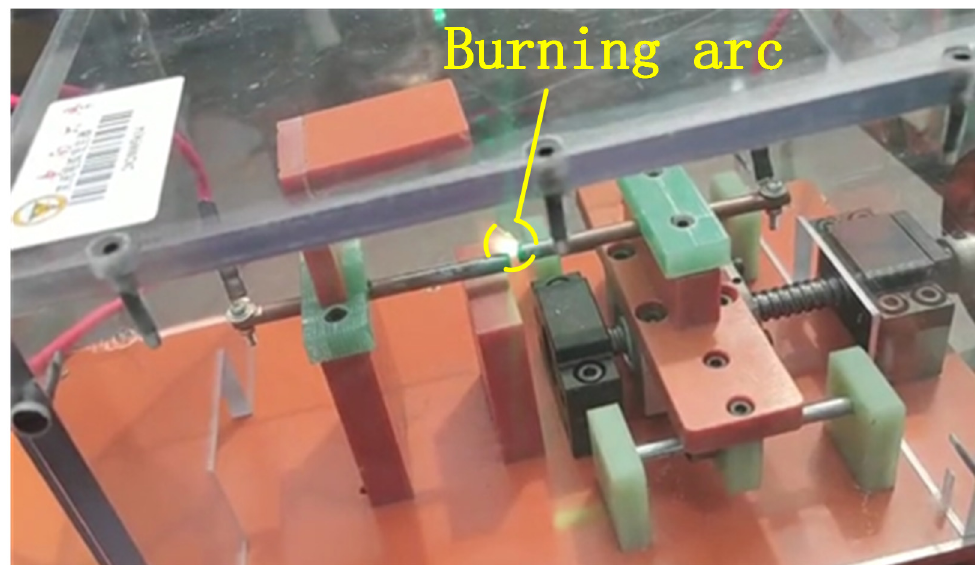
Figure 7. Photo of the arc.